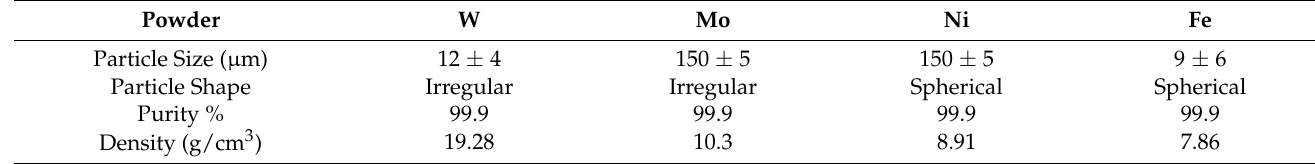
Figure 1. Powder morphology of ( a ) tungsten, ( b ) nickel, ( c ) iron, and ( d ) molybdenum. Table 1. Characteristics of W, Mo, Ni, and Fe metal powders.